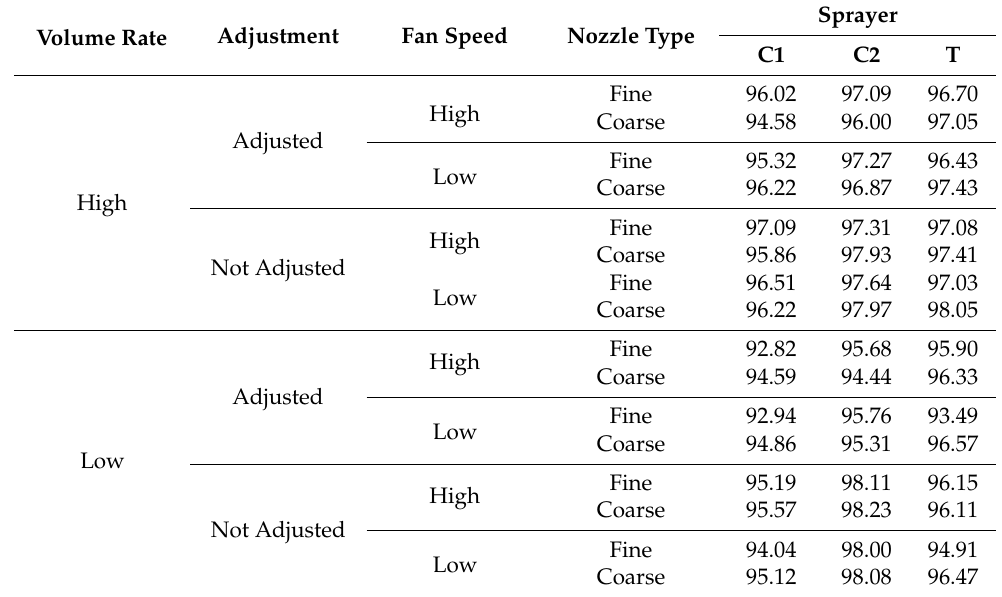
Table 4. SI(%)betweenthesprayers’sidesfortheverticalsprayprofilesofeachsprayerandeachconfiguration. Volume